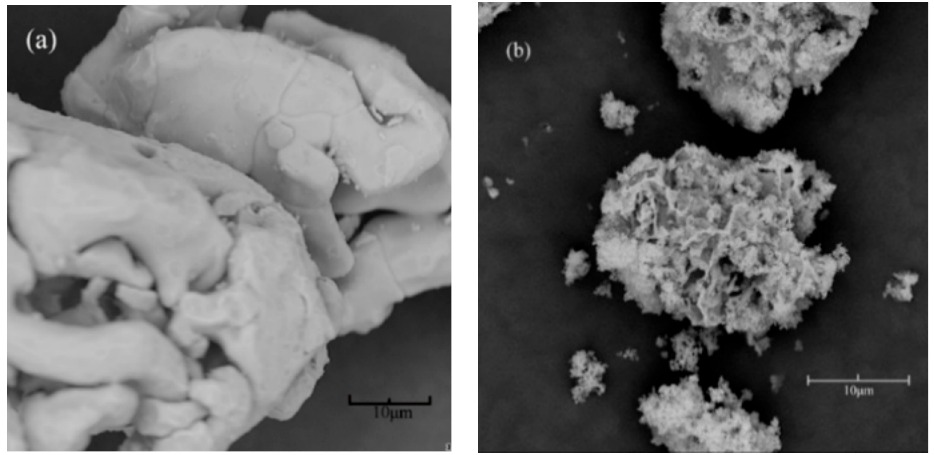
Figure 4. ( a ) SEM images of zero-valent iron (ZVI) at a reaction time of 0 min. ( b ) SEM images of ZVI at a reaction time of 30 min.